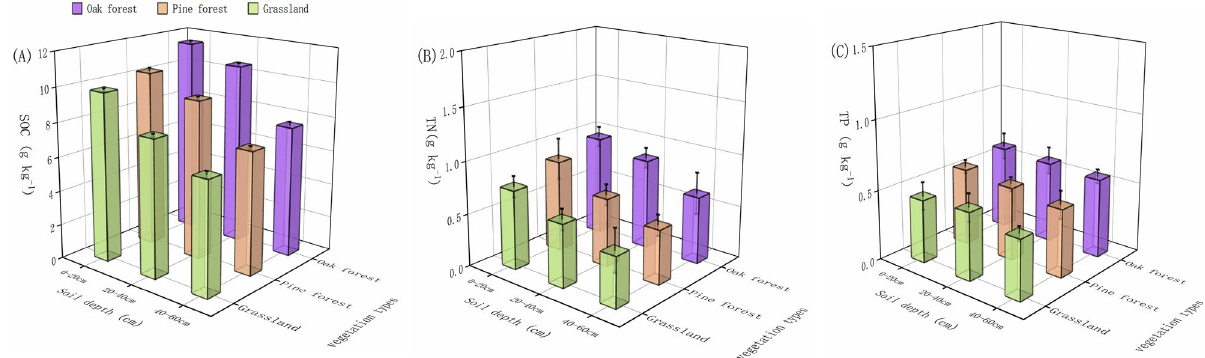
Figure 2. The SOC ( A ), TN ( B ) and TP ( C ) concentrations affected by vegetation types (oak forest, pine forest, and grassland) and soil depths of 0–20 cm, 20–40 cm, and 40–60